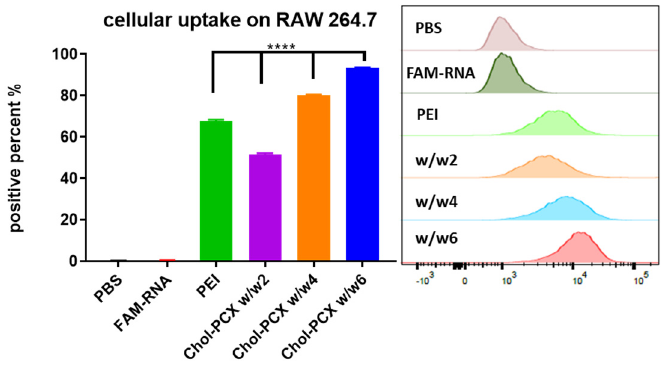
Figure 4. Uptake of Chol-PCX/miRNA nanoparticles after 4 h of incubation with RAW 264.7 macrophages by flow cytometry (histogram on the right). Data were analyzed by one-way ANOVA followed by Tukey’s comparison test. Data are expressed as mean ± SD ( n = 3). **** p < 0.0001.